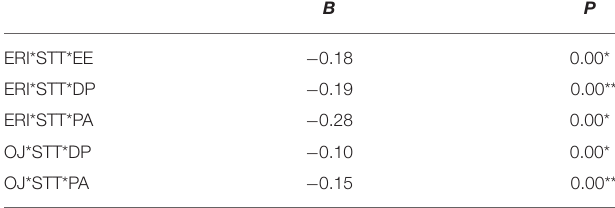
TABLE 5 | Summary of moderating effects.